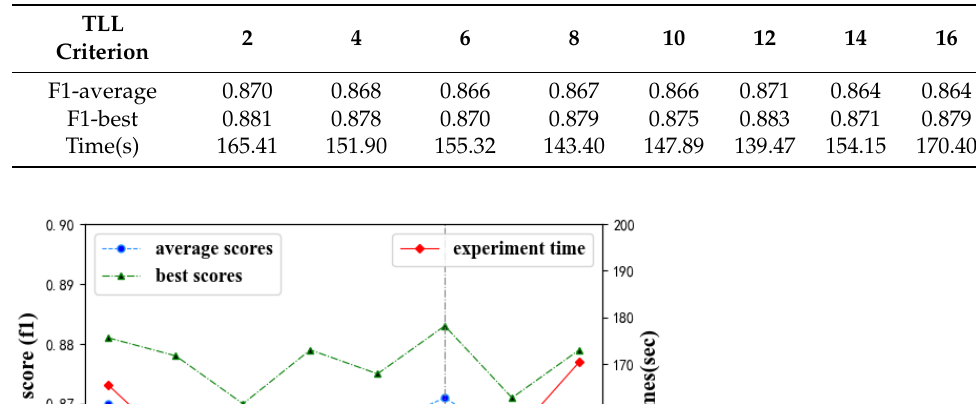
Table 5. Performance of prediction model under different TLL.